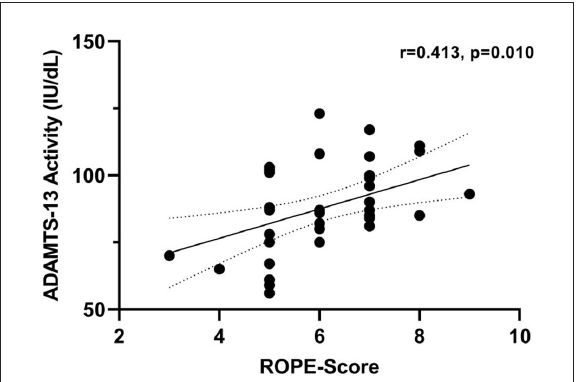
FIGURE3 Correlation between ADAMTS-13 activity and RoPE-Score in cohort 2. Correlation coefficients were calculated using Spearman’s rank correlation.